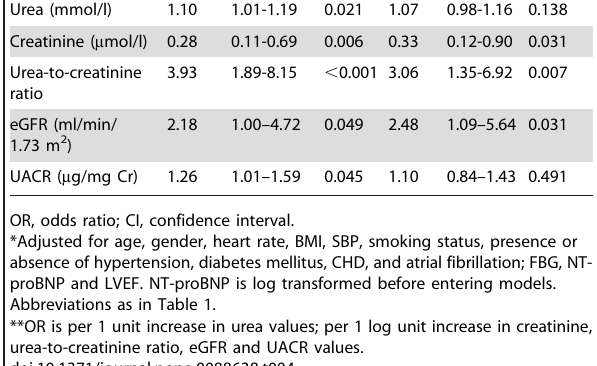
Table 3. The association of biochemical renal parameters with NT-proBNP.